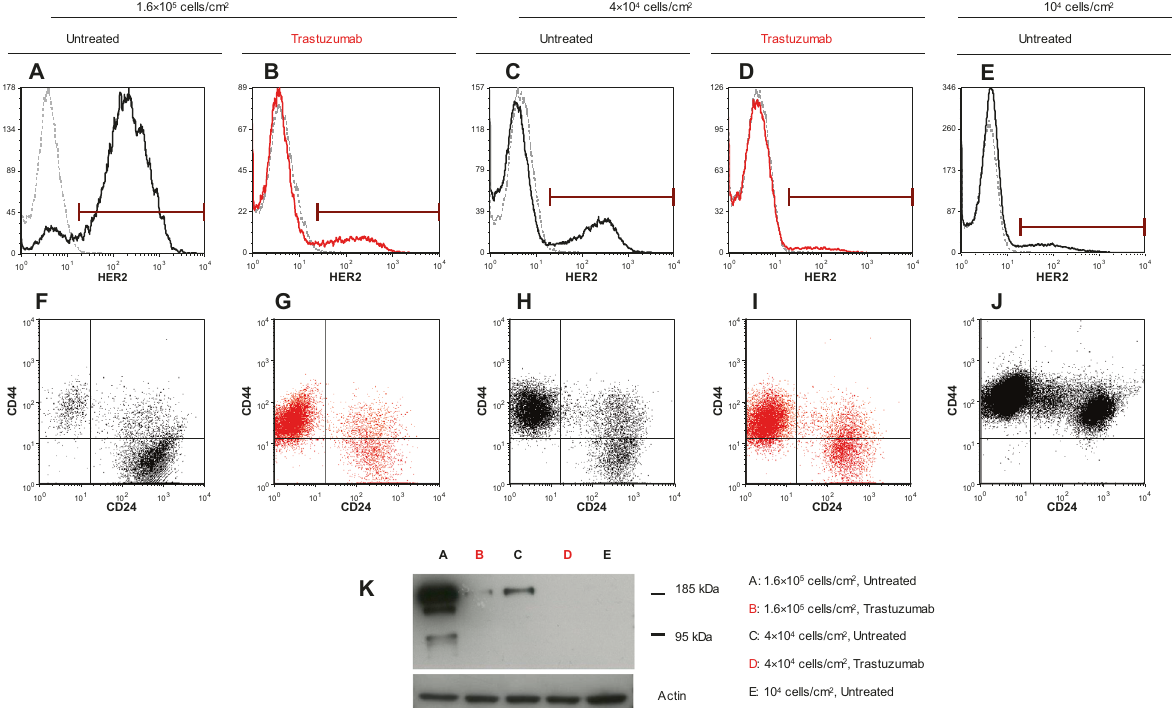
Fig. 5 Effect of cell seeding and trastuzumab on phenotypic pro fi le of MamBo43HER2 labile cells. Continuous cultures in control medium A , C , E , F , H , J or trastuzumab 30 µg/ml B , D , G , I . Level of HER2 A – E and stemness markers CD24 and CD44 F – J were measured by cyto fl uorimetric analysis. Cell seeding dose: 1.6 × 10 5 cells/cm 2 , 60 days of culture A , B , F , G ; 4 × 10 4 cells/cm 2 , 60 days of culture C , D , H , I ; 10 4 cells/cm 2 , 30 days of culture E , J . K Western blotting analysis for